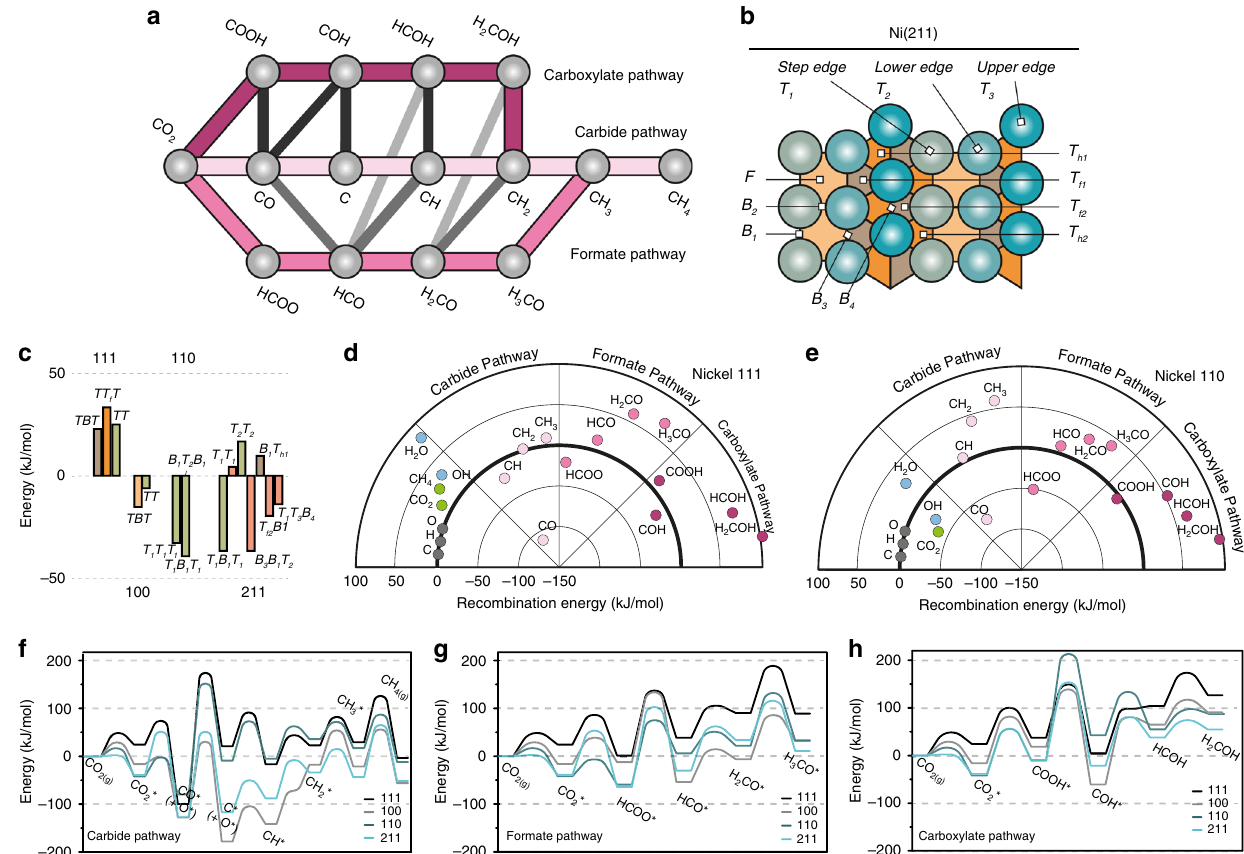
Fig. 2 Theoretical calculations of CO 2 activation over Ni. a Schematic including all possible reaction pathways for the carbon dioxide hydrogenation in pink, all intermediates are represented as gray dots. Gray lines indicate plausible links between the primary pathways. b Schematic representation of available sites (T 1 , T f1 , B 1 , … ) on a Ni(211) surface. c Chemisorption energies of CO 2 on different available sites of Ni(111), Ni(100), Ni(110), and Ni(211) crystal facets (T: top, B: bridge). d , e Recombination energies of the carbide, formate and carboxyl pathways on a terrace Ni(111), and a stepped Ni(110) crystal facet. The left panel in each respective fi gure shows the C, H, and O adatoms from which each intermediate is recombined, as well as reaction intermediates OH and H 2 O. The most stable adsorption site is set at zero-energy. f – h Potential energy diagrams for ( f ) the carbide pathway ( g ) the formate pathway, and ( h ) the carboxyl pathway on terrace facets Ni(111) and Ni(100), and stepped facets Ni(110) and Ni(211) of CO 2 hydrogenation as calculated by nudged elastic band understanding. To this end, nudged elastic band (NEB) calcula- should be equally facile on all Ni facets. Nevertheless, by comparing tions were performed, which yield activation energies ( E a ) for the position of the Fermi-level corrected MO ’ s of CO 2 ǂ in Fig. 3b, each respective reaction step. Figure 2f – h show the potential (here ǂ denotes the transition state in CO 2 * → CO* + O*, more information in Supplementary Fig. 23 and Supplementary Table 5), energy diagram for each reaction pathway and each examined we have a tool to rank nickel facets in order of activating effect per facet (Supplementary Fig. 19 lists the values for all forward- MO. For 2 Ʃ u the order is 111 < 110 < 211 < 100. From a DOS and backward-activation barriers). From the potential energy diagrams, of the three pathways, the carbide pathway is the lowest in energy. The activation energy of the CO 2 dissociation step (CO 2 * → CO* + O*) in this lowest-energy pathway vary greatly over the different facets, with no trend in terrace vs. stepped (100) activates CO 2 the best (in CO 2 * → CO* + O*): it activates the